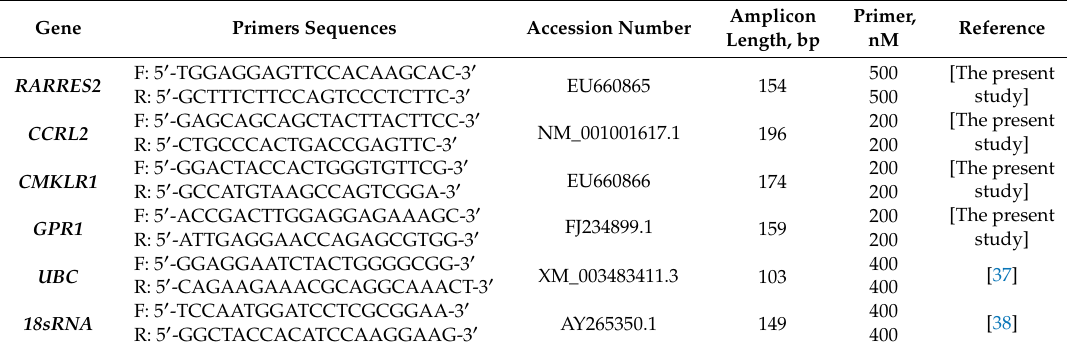
Table 1. Characteristics of primers used in the